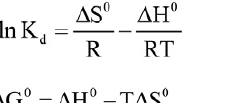
Figure 5. Influence of initial aluminium concentration on the ad- sorption process.